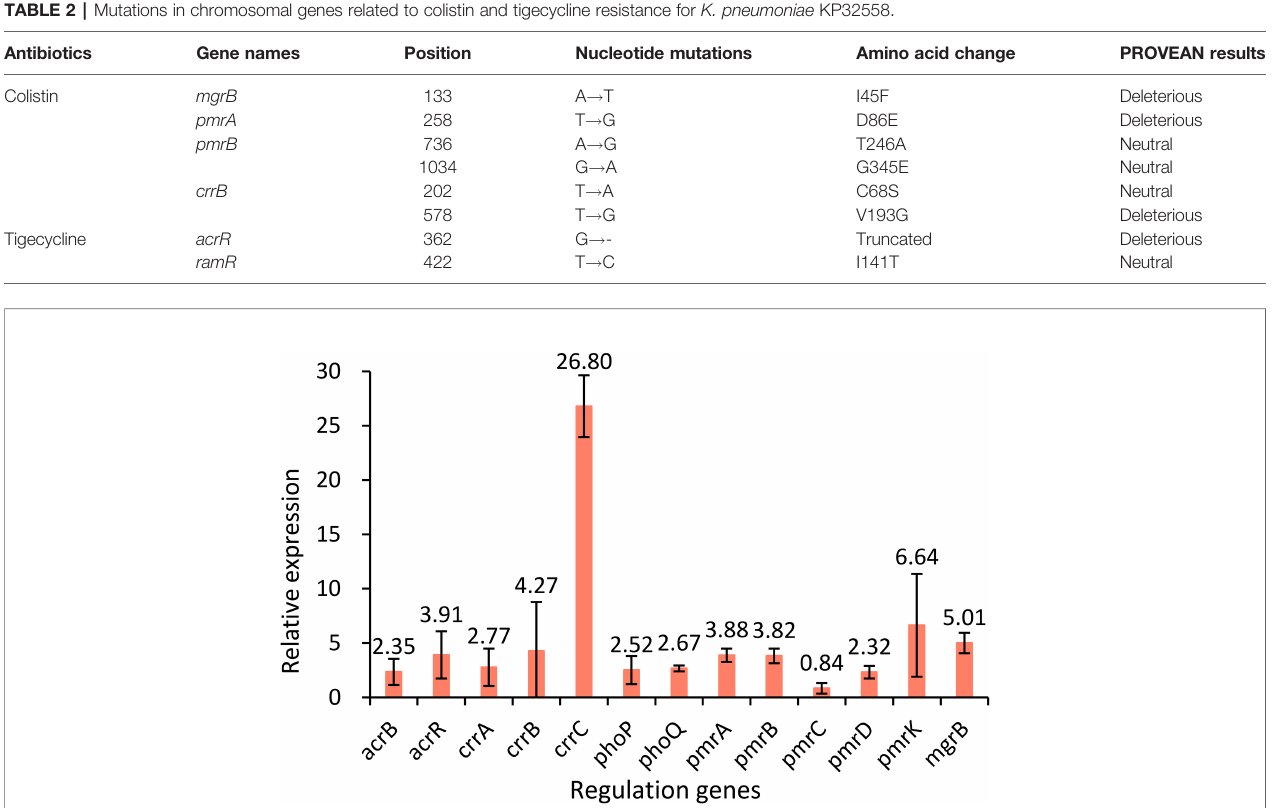
FIGURE 3 | Relative expression levels of the acrB , acrR , crrA , crrB , crrC , phoP , phoQ , pmrA , pmrB , pmrC , pmrD , pmrK and mgrB genes in strain KP32558 compared with those in the antibiotic-susceptible K. pneumoniae strain ATCC13883. Values are the means and the standard deviations from three independent